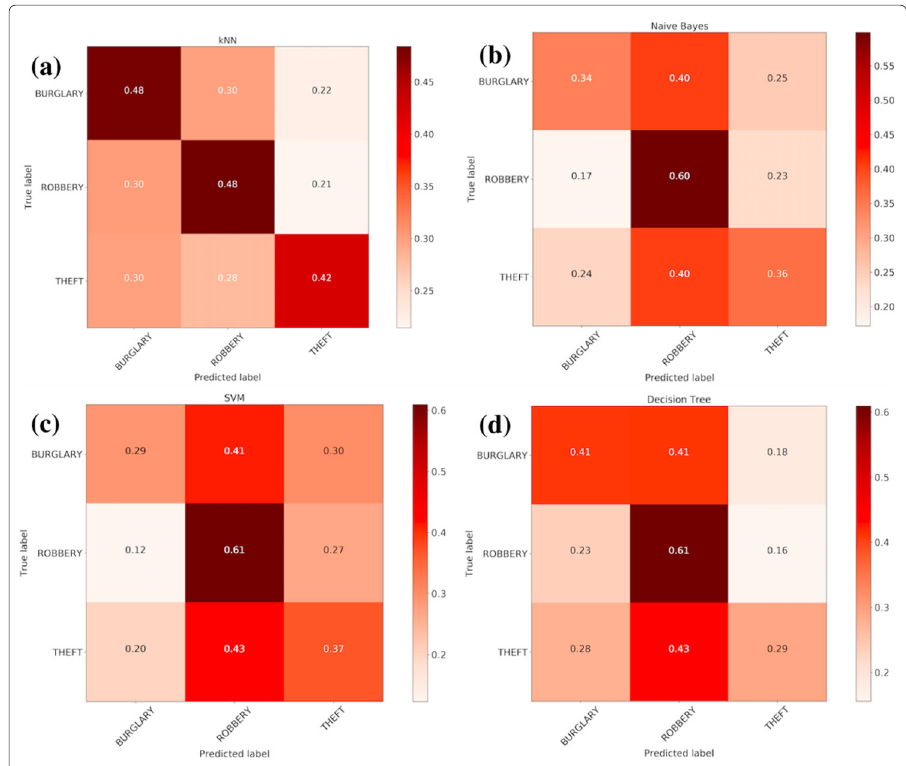
Fig. 7 Confusion matrix for performance analysis of four different classification algorithms. a kNN (k-nearest neighbors), b Naive Bayes, c SVM (support vector machine) and d decision tree algorithms for classifying crime incidents into the top three most frequent crime categories occurring in the City of Chicago